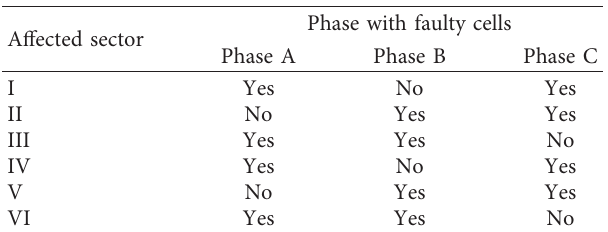
Table 1: Affected sector by fault.